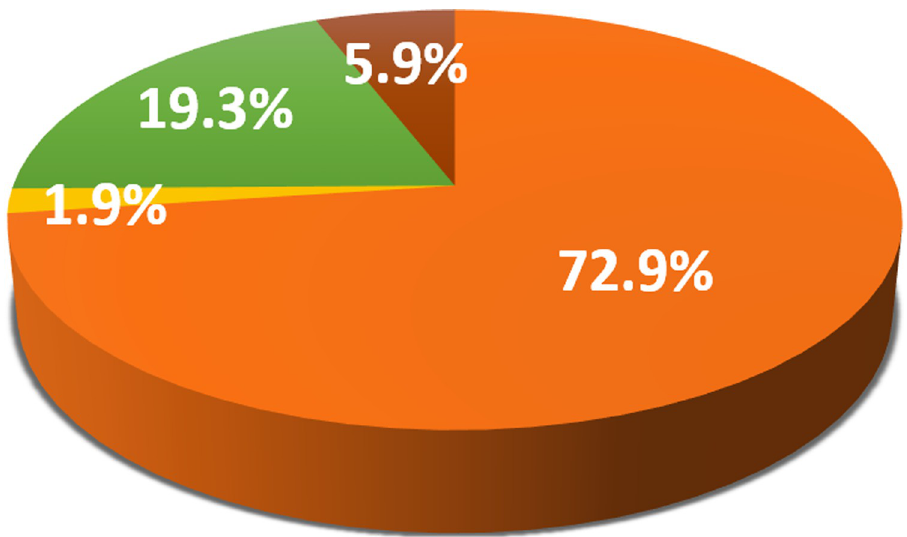
Fig 6. Detection percentages for nPCR. Positive samples to T . equi (orange), positive samples to B . caballi (yellow). Double-negative (green). Double-positive (brown).